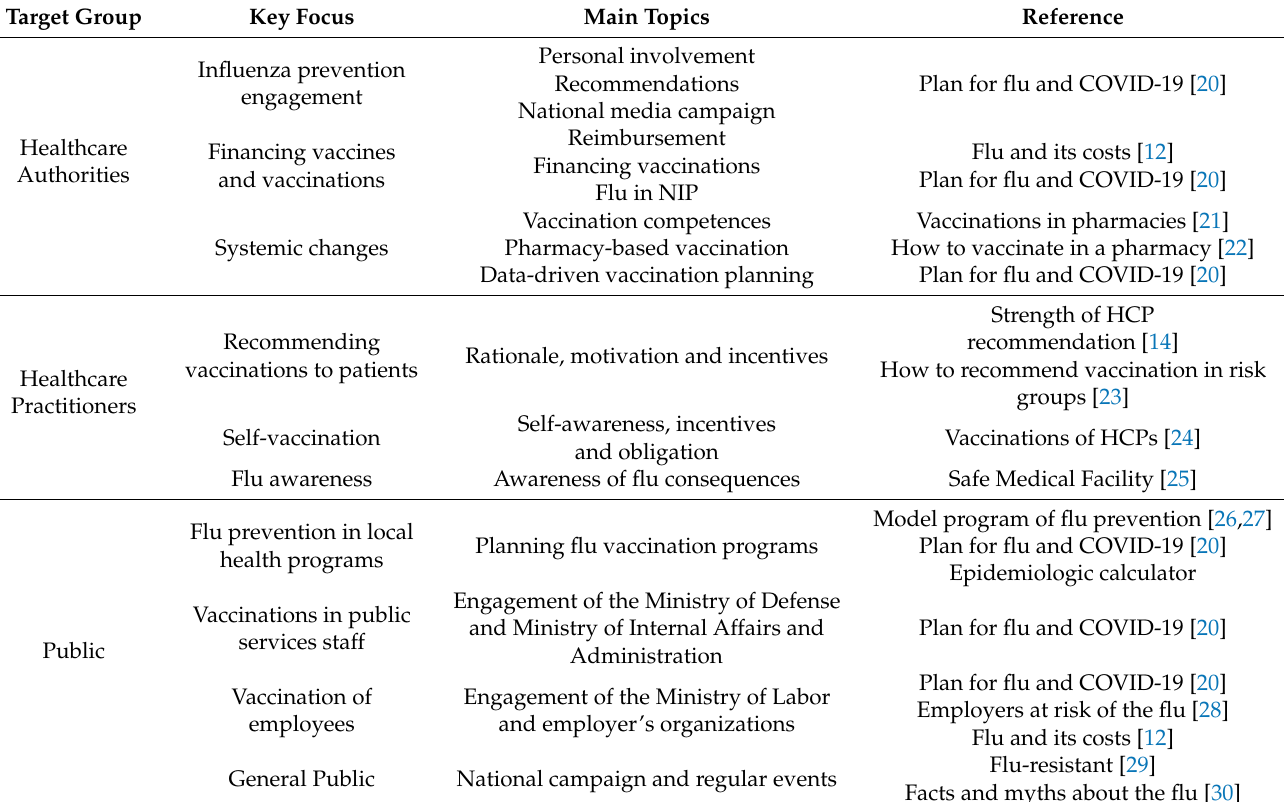
Figure 2. Main actions of the NPIP and milestones of evolution of influenza vaccination in Poland, * -50% reimbursement of influenza vaccine for patients aged 65–74 years old and 100% reimbursement for patients ≥ 75 years old; **-50% reimbursement of influenza vaccine for patients aged 18–64 years old from risk groups, pregnant women, and children aged 2–5 years old. Table 1. Target group, focus, and main communication topics released by the National Program for Influenza Prevention until 2022.